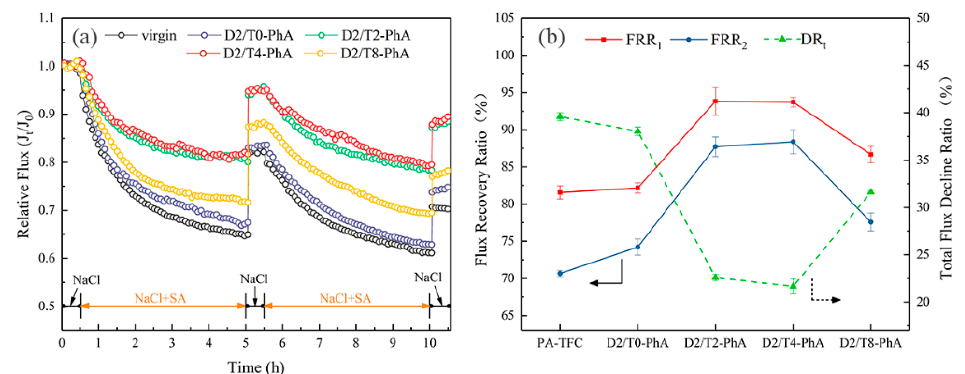
Figure 5. ( a ) Time-dependent relative water flux and ( b ) FRR i values and DR t values of PA-TFC and DA/TA-PhA membranes tested with 2000 mg·L − 1 NaCl and 100 mg·L − 1 BSA aqueous solution.